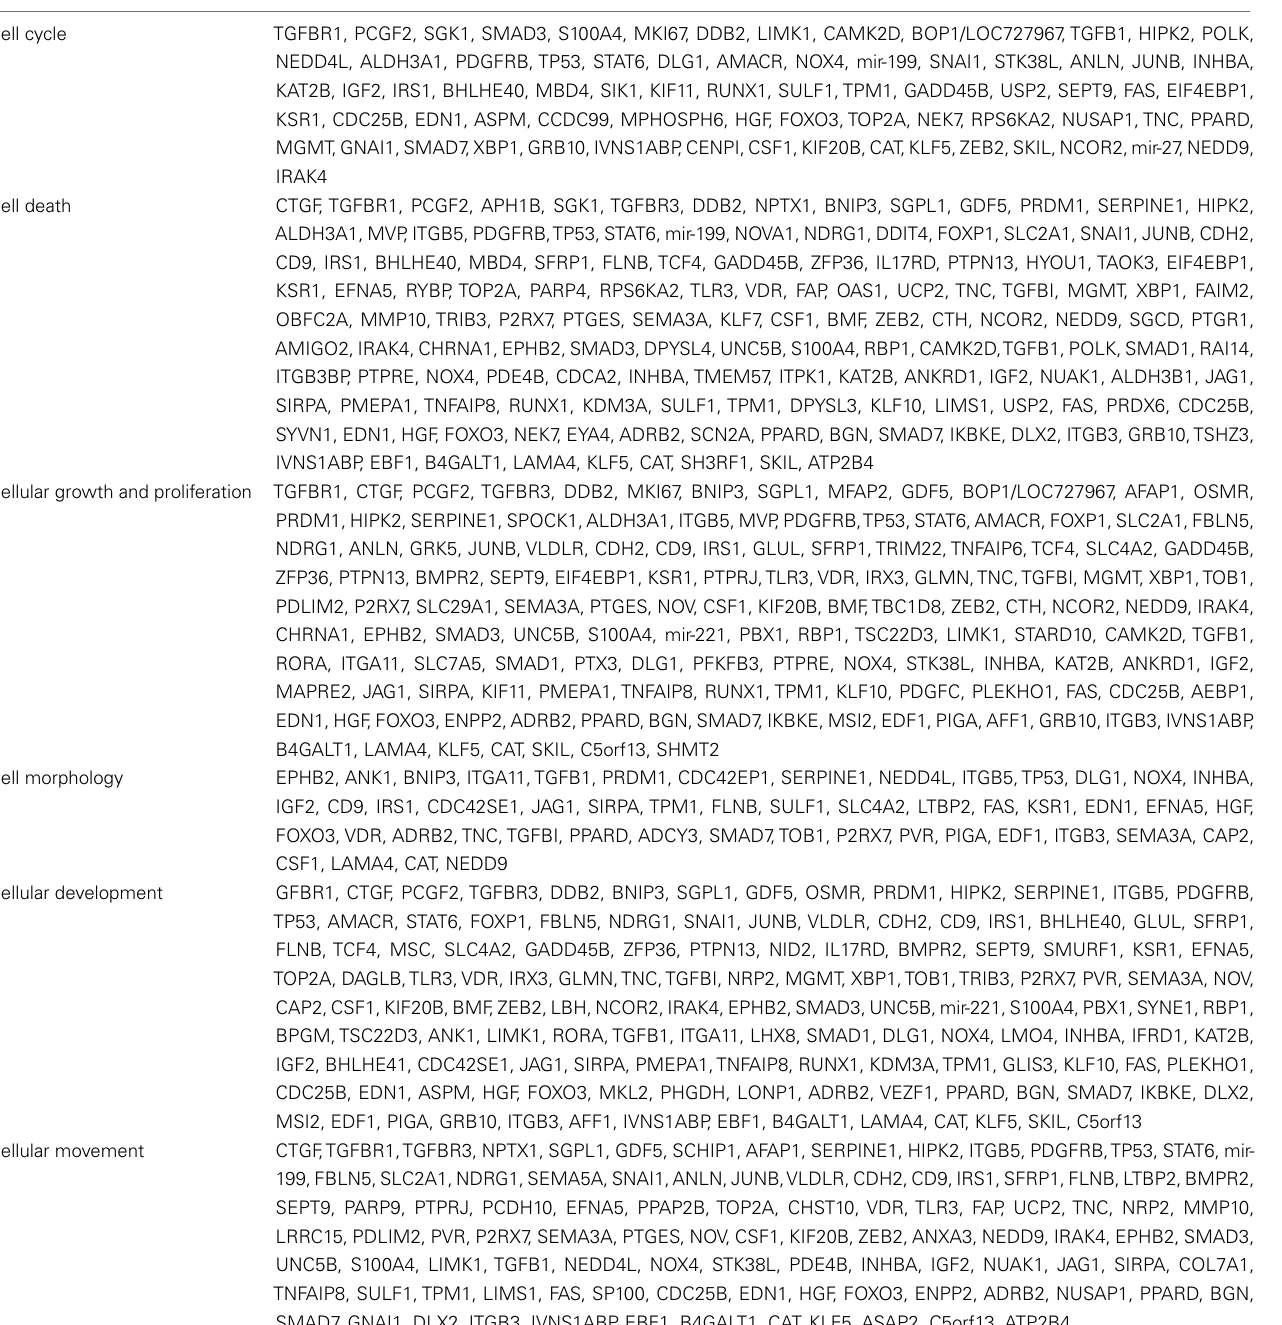
Table 1 | Differentially expressed molecules clustered into GO of cellular biofunctions. Function